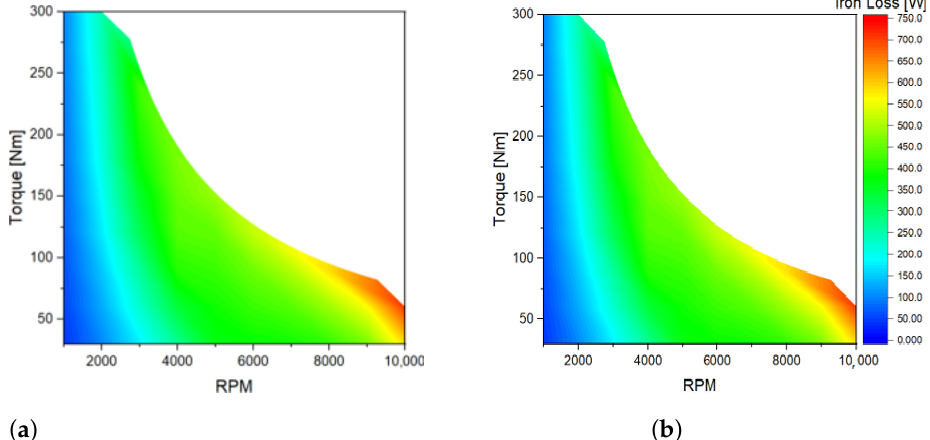
Figure 14. Iron loss maps: ( a ) conventional method. ( b ) proposed method.